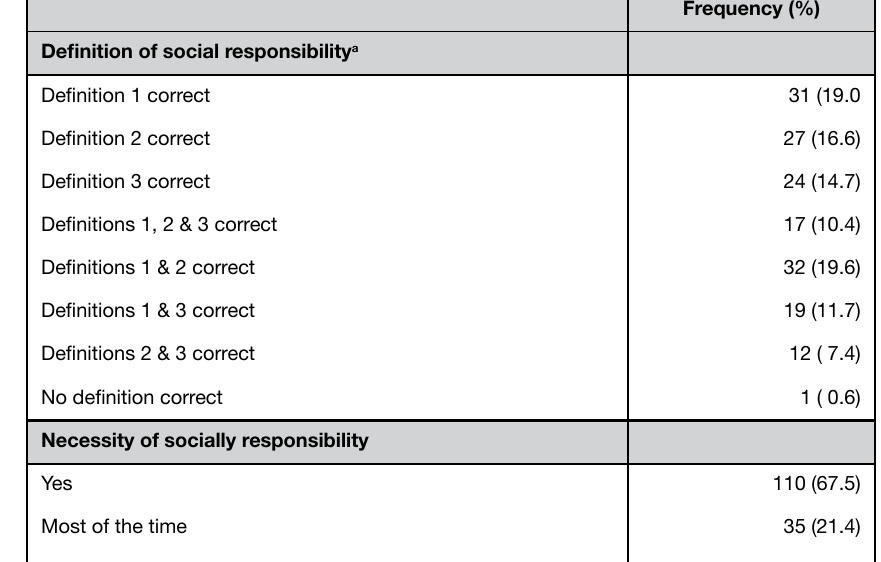
Table 2: Views on Social Responsibility